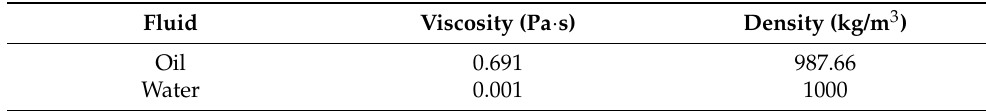
Table 1. Physical properties of the fluids considered in this study.